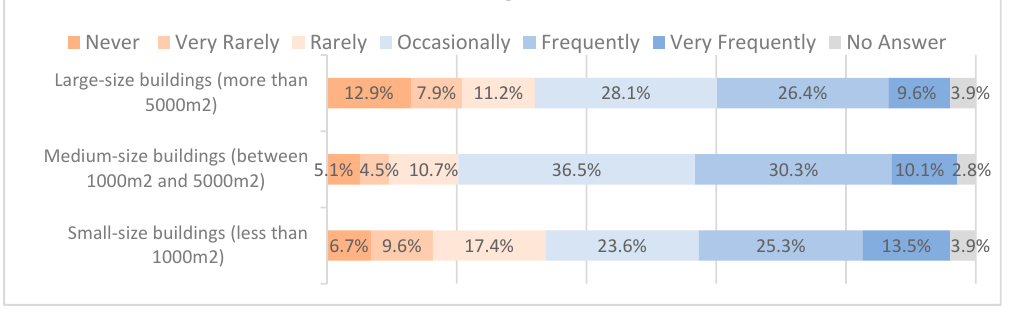
Figure 11. Trend chart of the frequency of work on scan-to-BIM projects according to the size of the building. Regarding the characterization of the building by its age and classification as a listed building, the trend identified was a prevalence of the use of laser scanning and photo- grammetry in the digital survey of non-listed recent buildings up to 100 years old; 44.4% indicated that they work with these cases frequently or very frequently. This number was 25.3% for non-listed old buildings, and for listed old buildings, it dropped to 20.2% (Figure 12).